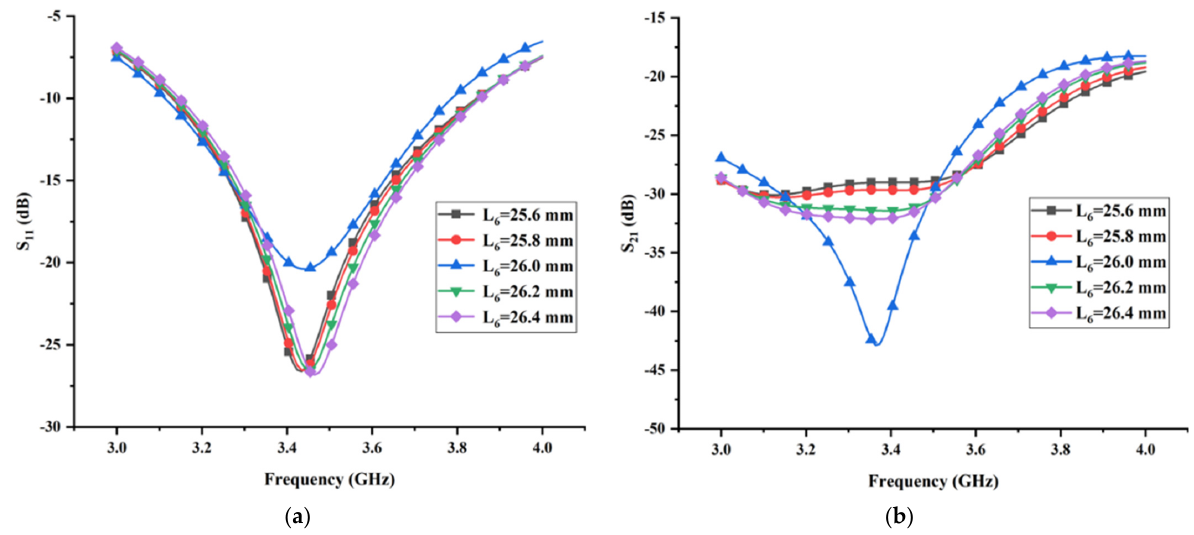
Figure 14. The effects of the length L 6 of the thin horizontal stub on ( a ) reflection coefficient and ( b ) transmission coefficient.